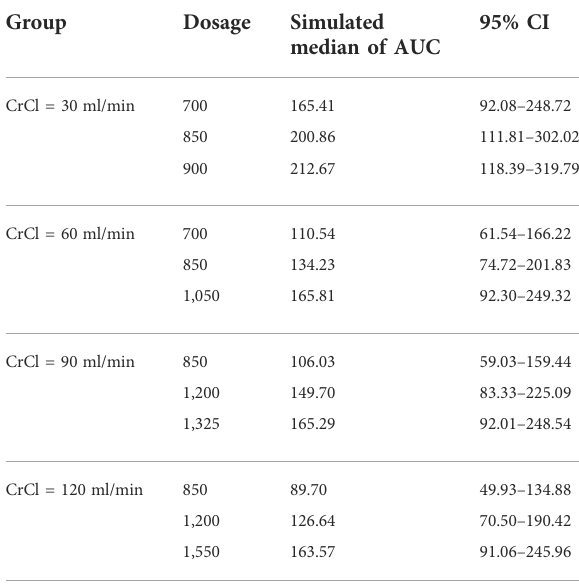
TABLE 3 The simulated PEM exposure of various dosing regimens in patients with different renal function. Group